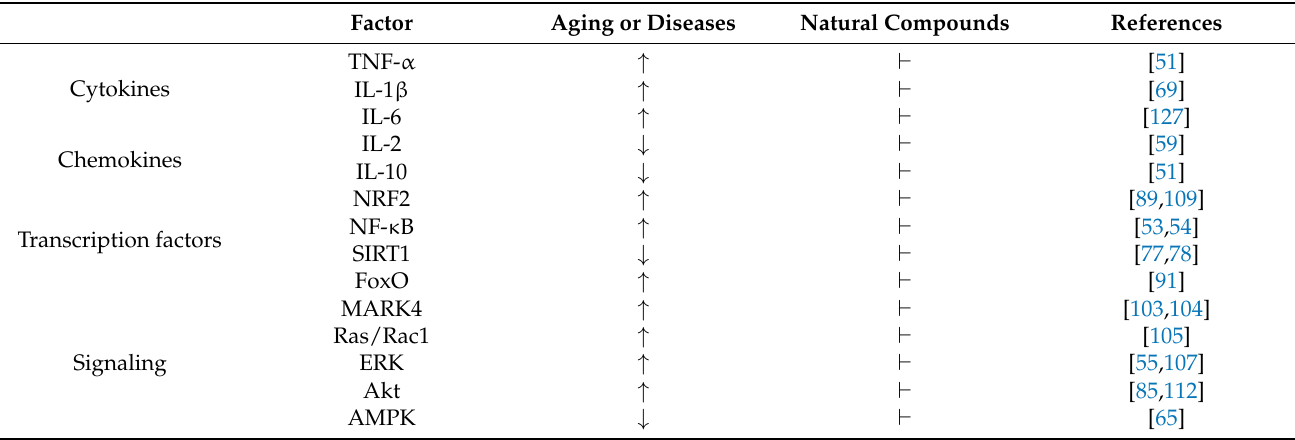
Table 2. Effect of natural compound in inflammation-mediated aging and various diseases. Factor Aging or Diseases Natural